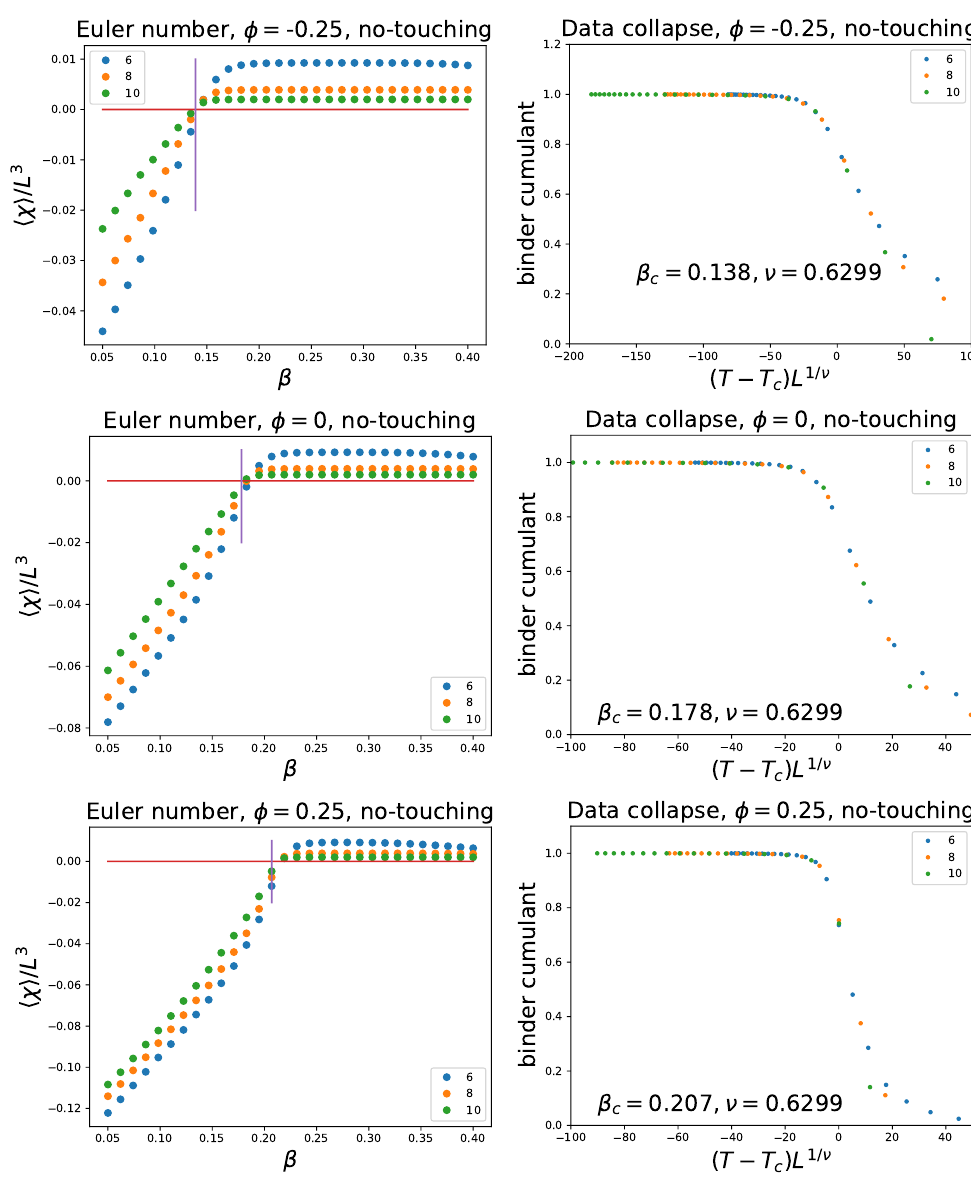
Figure 13: Scans varying β while holding φ fixed for no-touching protocol. Left column: Euler character per unit volume χ/ L 3 . Right column: Binder cumulant as ) L 1 ν . In the Euler number plots, we display a a function of scaling variable ( β − β c vertical line at β = β (determined from the best collapse of the binder cumulant), c and a horizontal line at 〈 χ 〉 =